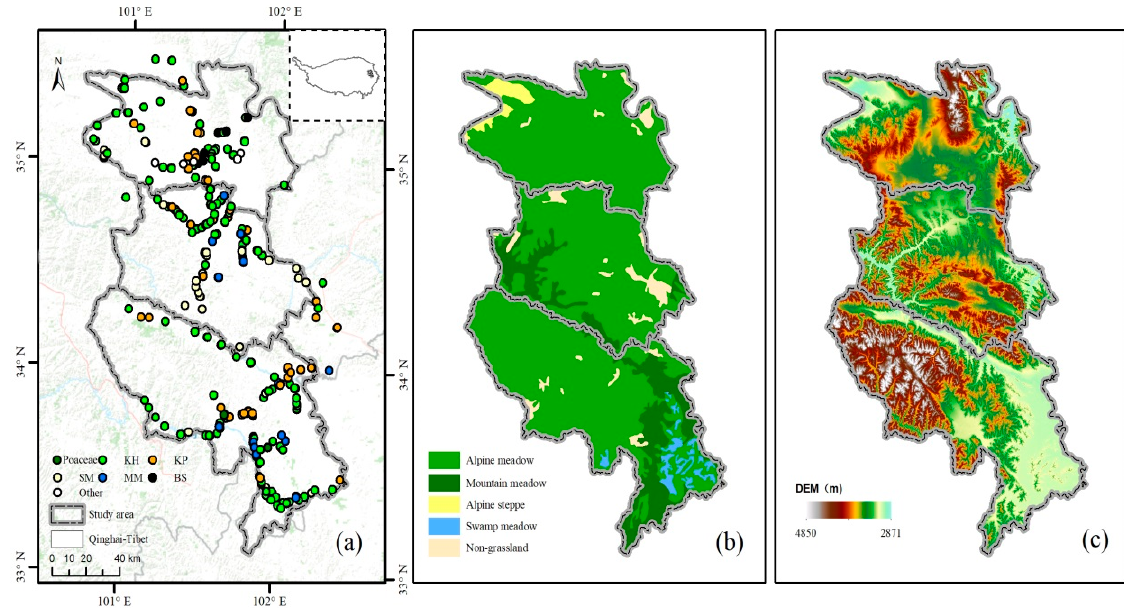
Figure 1. Location, grassland type and topography of study area. ( a ) Location of the study area in Qinghai – Tibetan Plateau and the observation sites; dots of different color represent the vegetation communities. Poaceae: Elymus nutans + Stipa silena + Festuca ovina community, KH: Kobresia humilis community, KP: Kobresia pygmaea community, BS: black soil type, MM: marsh meadow, SM: shrub meadow. ( b ) Grassland type of study area; ( c ) topography of study area.